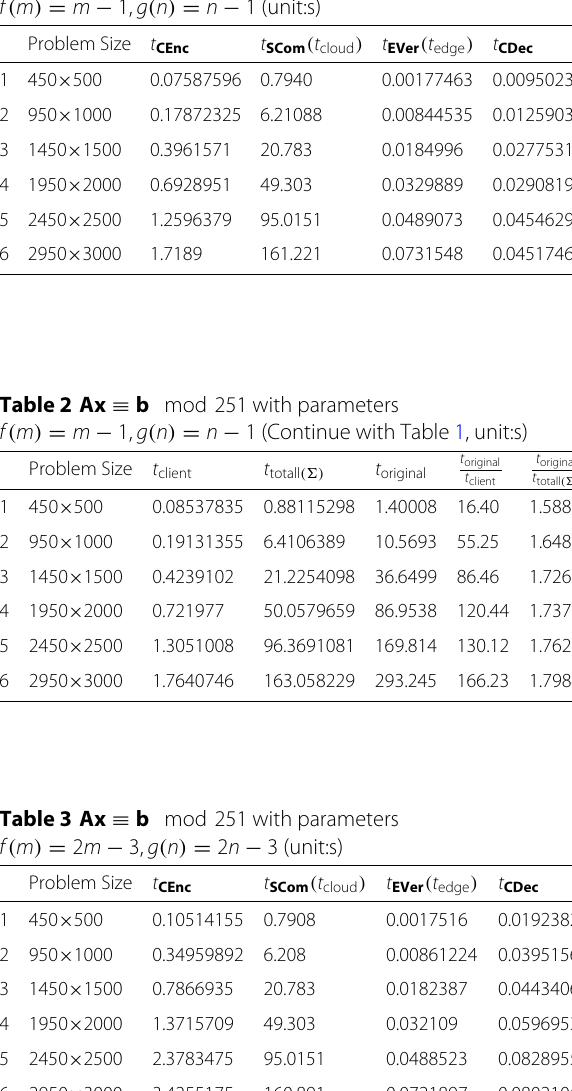
Table 1 Ax ≡ b mod 251 with parameters